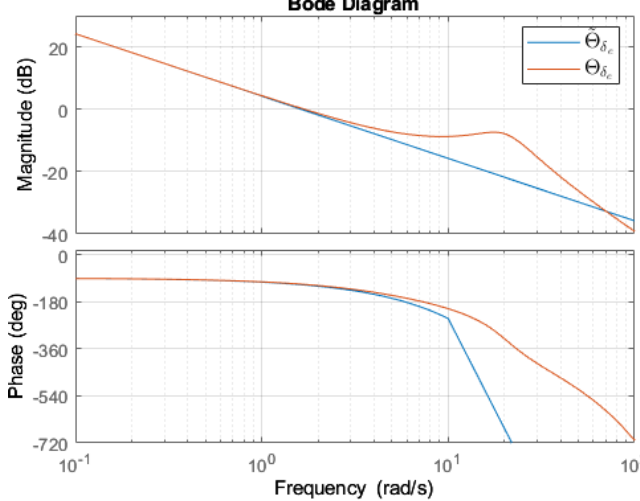
Figure 10. Comparing Bode plots of plant model (14) (red) and (15) (blue).